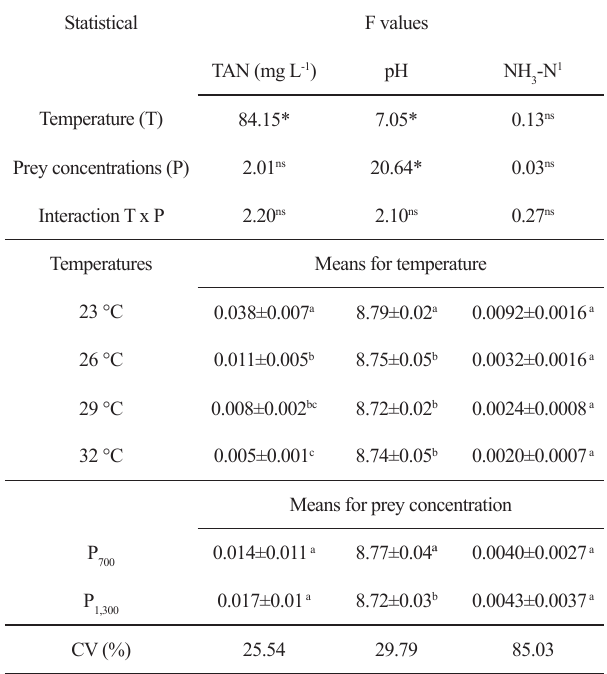
Table 1 . Total ammonia nitrogen (TAN), pH and unionized -N) during the larviculture of ammonia nitrogen (NH 3 Lophiosilurus alexandri at different temperatures and prey concentrations. F values and means ± standard deviation ( P <0.05). Means followed by the same letters on the columns did not differ by Tukey’s test ( P <0.05). * P